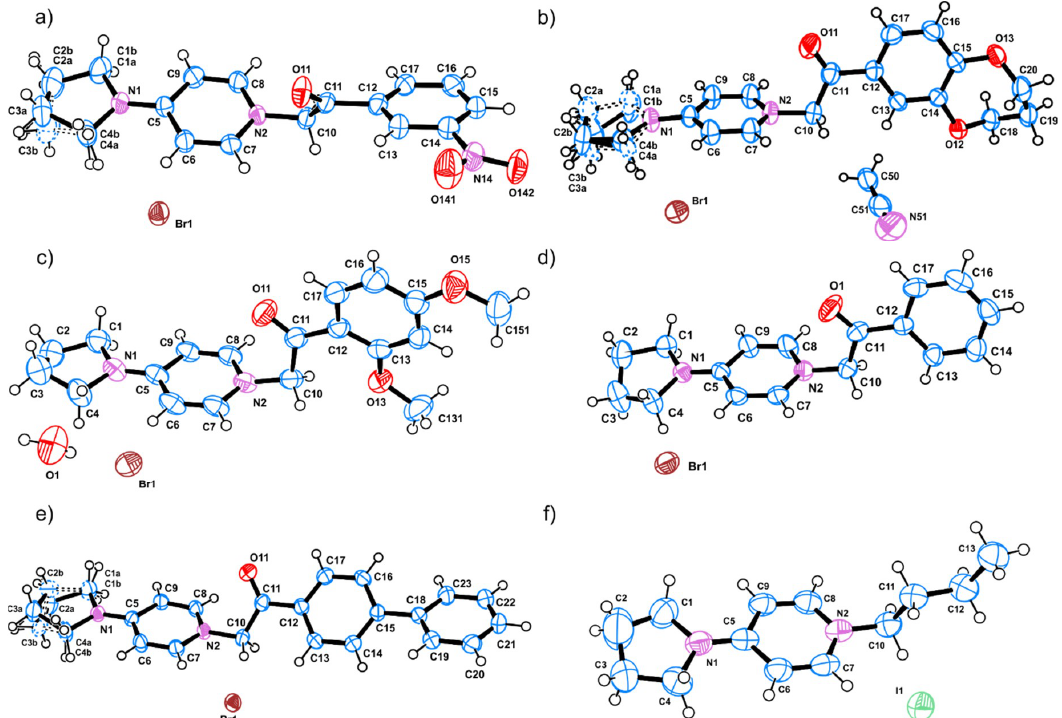
Figure 1. ORTEP [39] views of the molecules in the ASU of the crystal structures of ( a) compound 1 , ( b ) compound 2 , ( c ) compound 3 , ( d ) compound 4 , ( e ) compound 5 , and ( f ) compound 6 . The thermal ellipsoids are drawn with 50% probability level and all atoms are given with an appropriate labeling scheme.